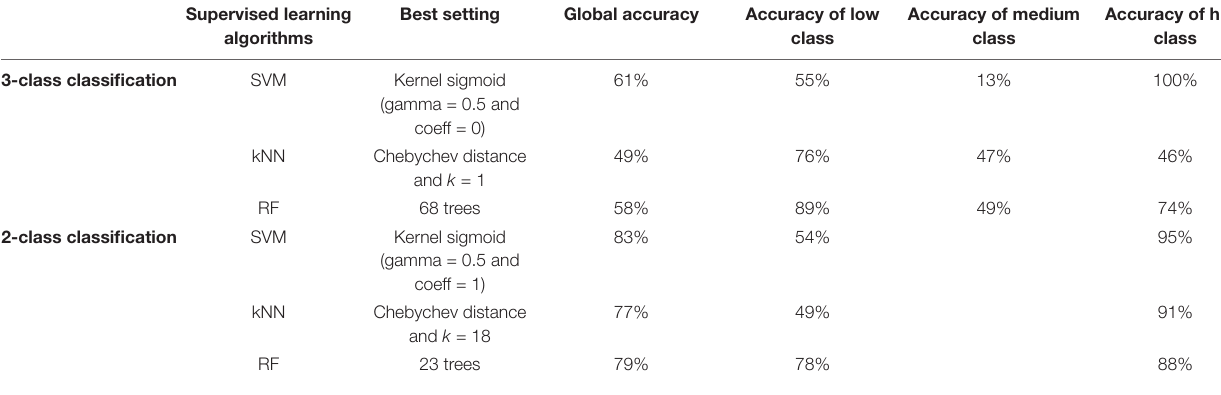
TABLE 3 | Accuracy of classification over all participants.